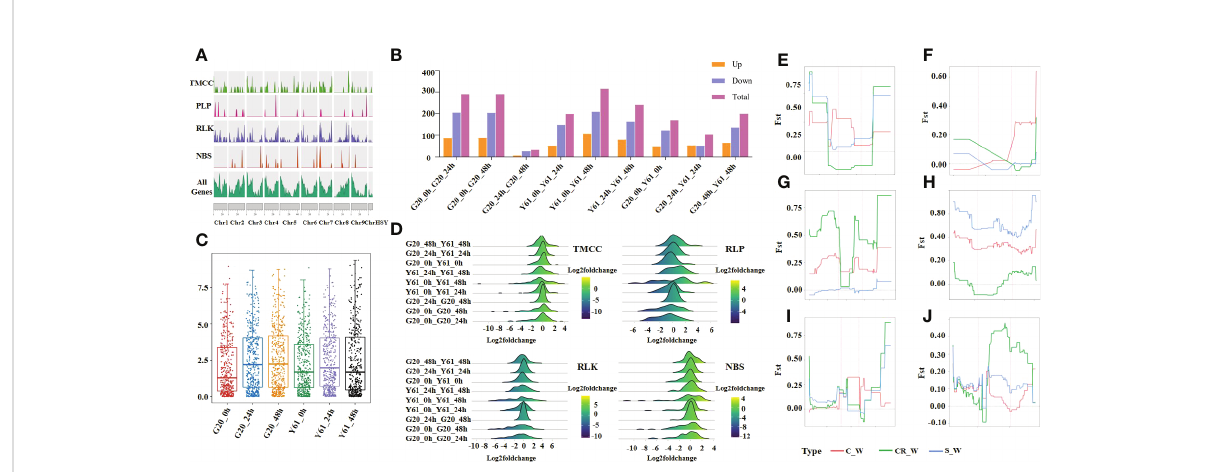
FIGURE 4 Genome-wide identi fi cation and analysis of RGAs in papaya. (A) , Density map of chromosome distribution of different RGA types on papaya chromosomes. (B) , Number of differentially expressed RGA genes between groups; (C) , Box-plot of RGA gene expression (FPKM) in different groups; (D) , log 2 (fold-change) distribution; (E – J) , Fst values between sunset02G0021170, sunset06G0008770, sunset07G0001330, sunset07G0007900, sunset07G0021830, and sunset09G0019560 in costa rican (CR), common (C), and solo (S) populations and wild-type (W) population.